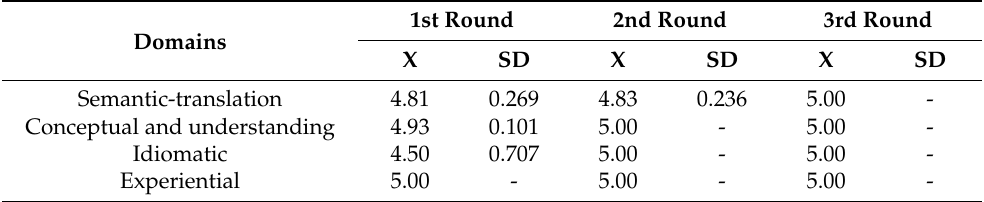
Table 3. Results of the three Spanish versions of the Back Pain and Body Posture Evaluation Instrument (BackPEI) carried out by the Expert Committee using the 5-point Likert scale.